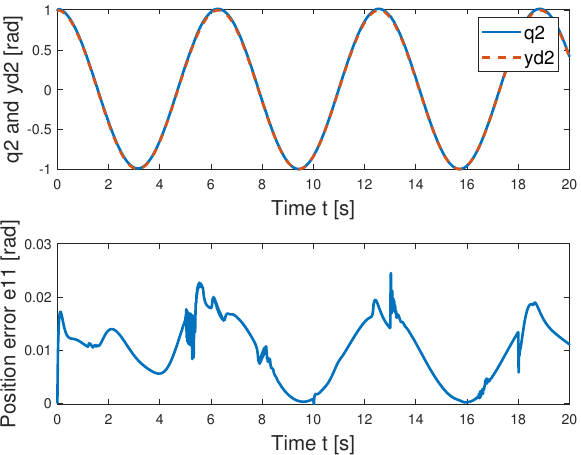
Figure 4. q 2 position trajectory and tracking error e 12 (MB control).